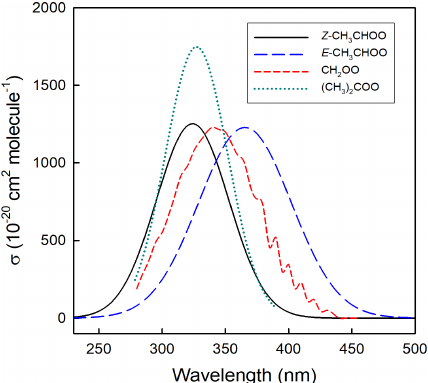
Figure 3. Recommended spectra for CH 2 OO, Z -CH 3 CHOO, E - CH 3 CHOO and (CH 3 ) 2